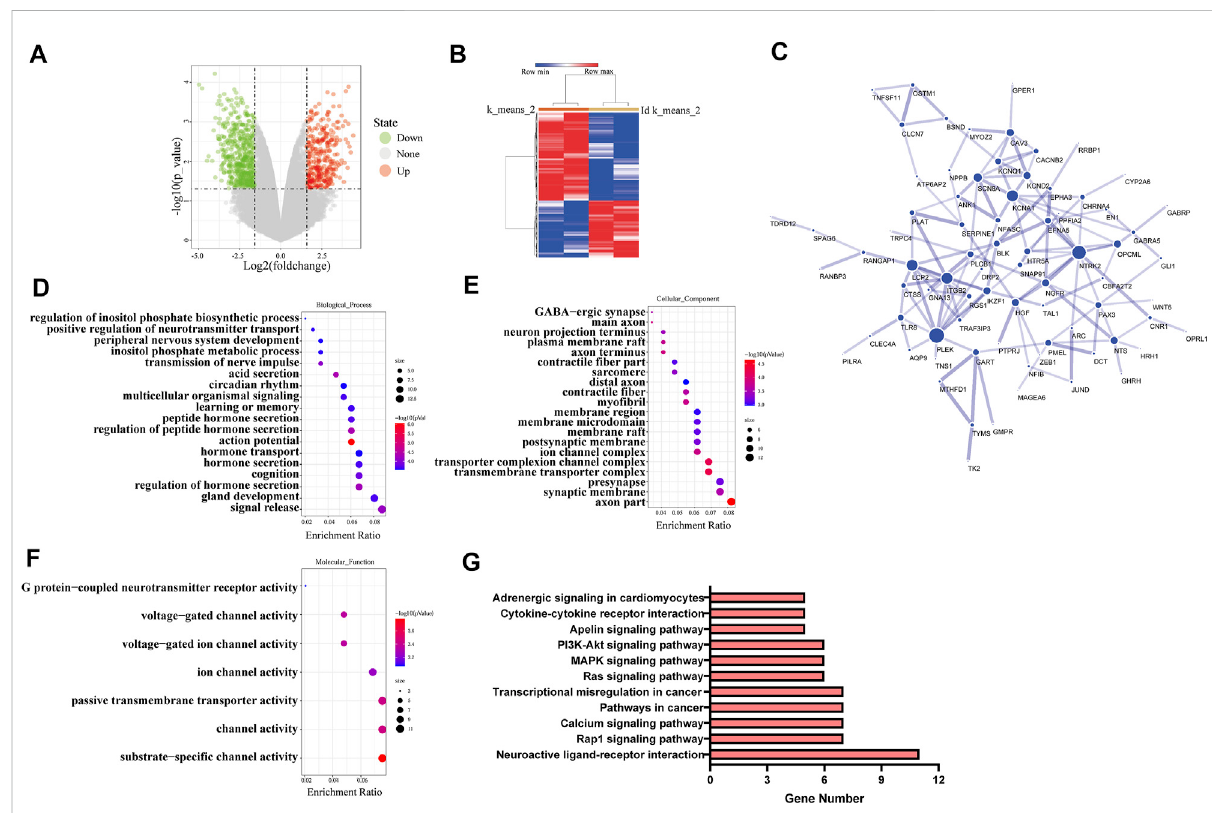
Puerarin effected multiple functions and signal pathways of cancer cells. (A) The volcano plot of differentially expressed genes (B) The hierarchical clustering of differentially expressed genes. (C) The protein-protein interaction network of differentially expressed genes (D – F) The GO analysisresultsofdifferentiallyexpressedgenes, (D) Biologicalprocess, (E) Cellularcomponent, (F) Molecularfuction (G) TheKEGGanalysisresultsof differentially expressed